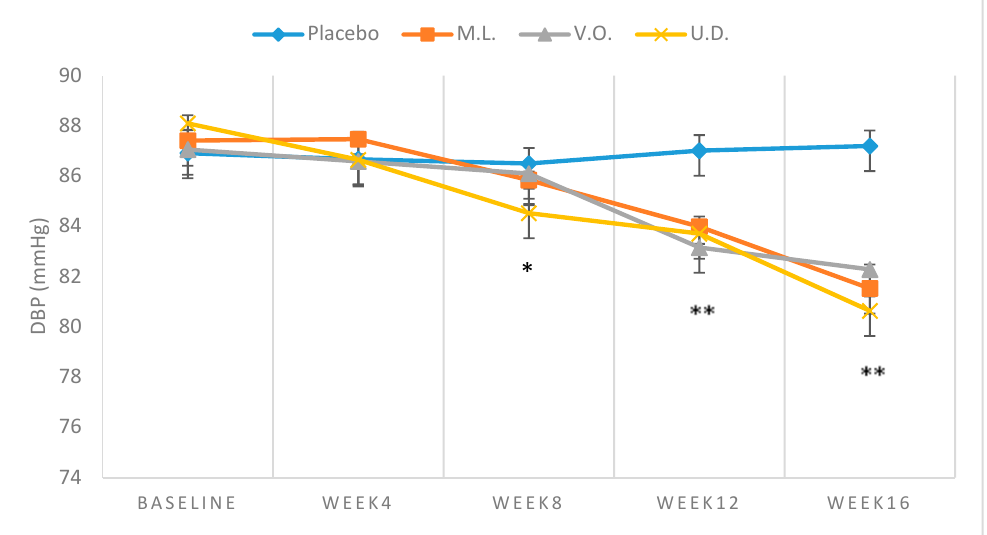
Figure 2. Means ± SD of DBP, measured over 16-week intake of 300 mL/day of M. longifolia (M.L.), V.odorata (V.O.) and U. dioica (U.D.) in mild hypertensive subjects.* p < 0.05 (U.D. compared to Placebo), ** p < 0.01 (M.L., V.O., and U.D. compared to Placebo).